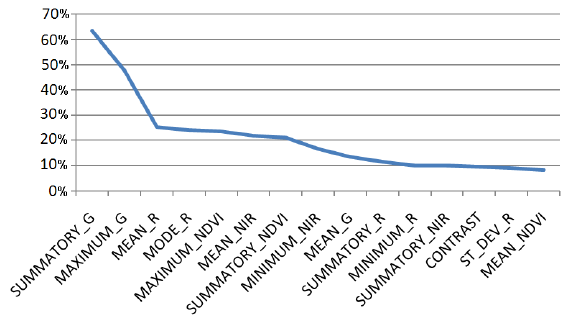
Figure 3: Relevance of features in classification of RapidEye image.